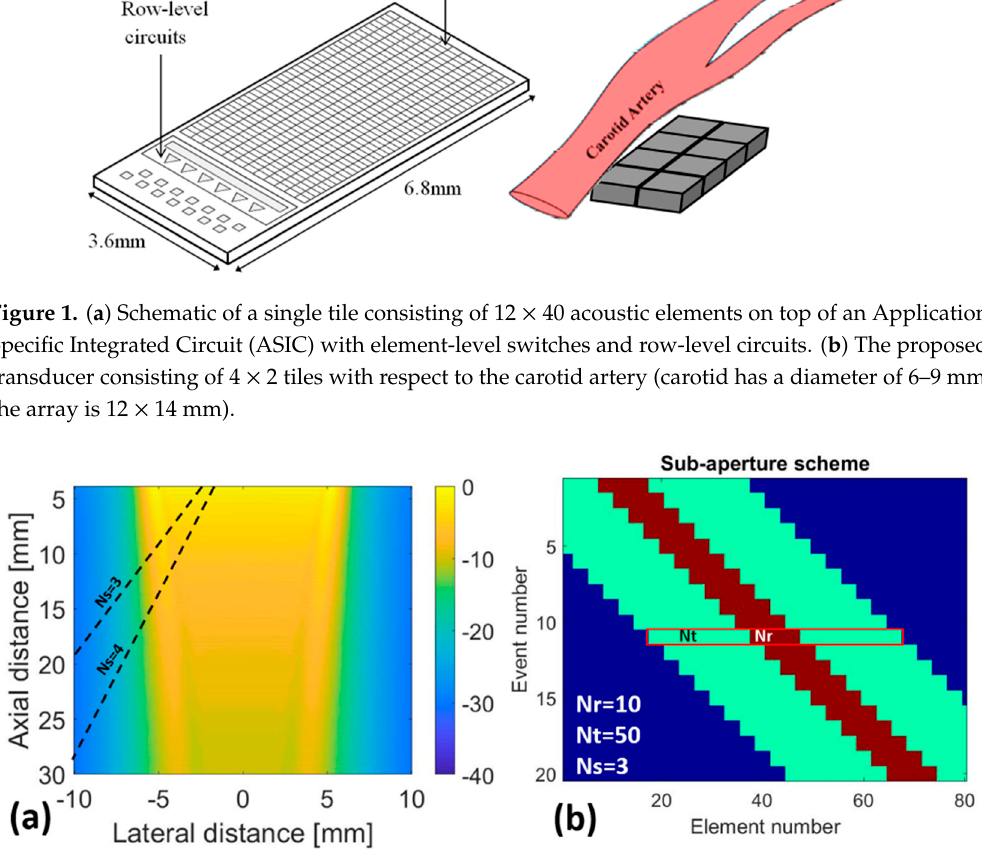
Figure 2. ( a ) The generated pressure field with a full transmission approach (all the elements are excited together); the dashed lines show the direction of grating lobes with different Ns. ( b ) A schematic of the aperture definition procedure; Ns = 3, Nr = 10, and Nt = 50. Receive and transmit apertures have the same center. Table 1. The variables used in the numerical